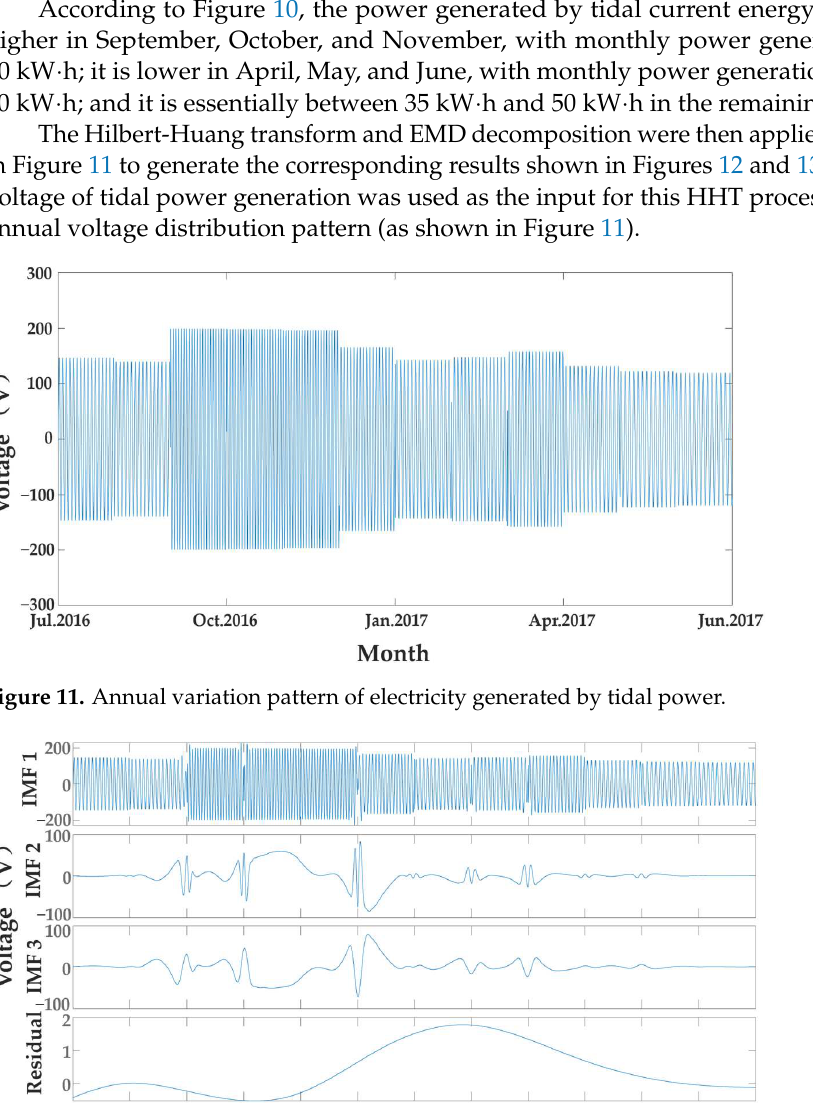
Figure 10. Monthly distribution of tidal power generation (2016–2017).